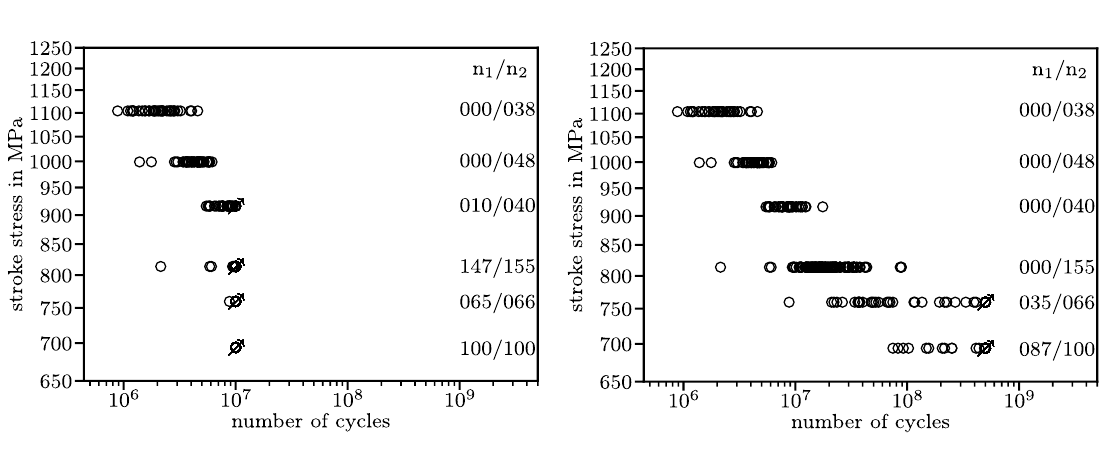
Figure 1. Results of a fatigue test up to 10 7 cycles ( left ) and after 5 · 10 8 cycles ( right ), data from